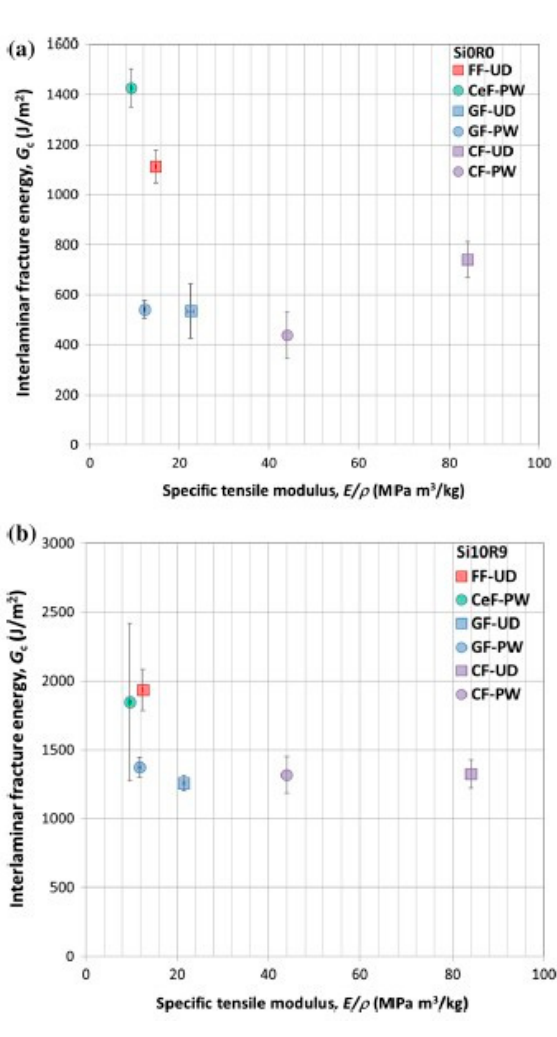
Figure 18. Fracture energy versus modulus for various laminates with unmodified epoxy resin and epoxy resin modified with 10 wt % nanosilica ( a ) and 9 wt % CTBN ( b ) [80].